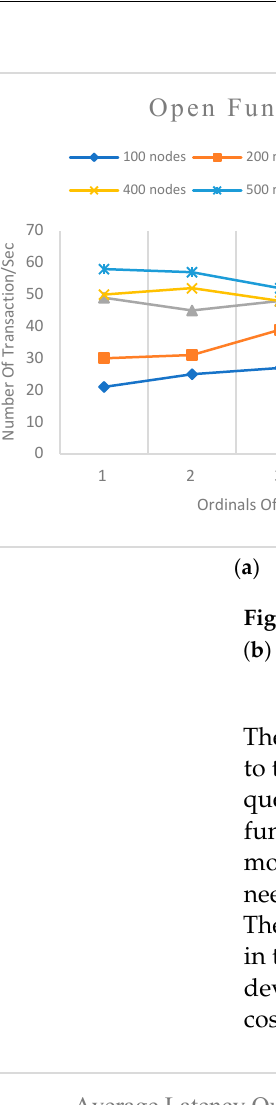
( b ) Figure 8. System ( a ) Transactions per second (TPS) of query function with varying node groups ( b )